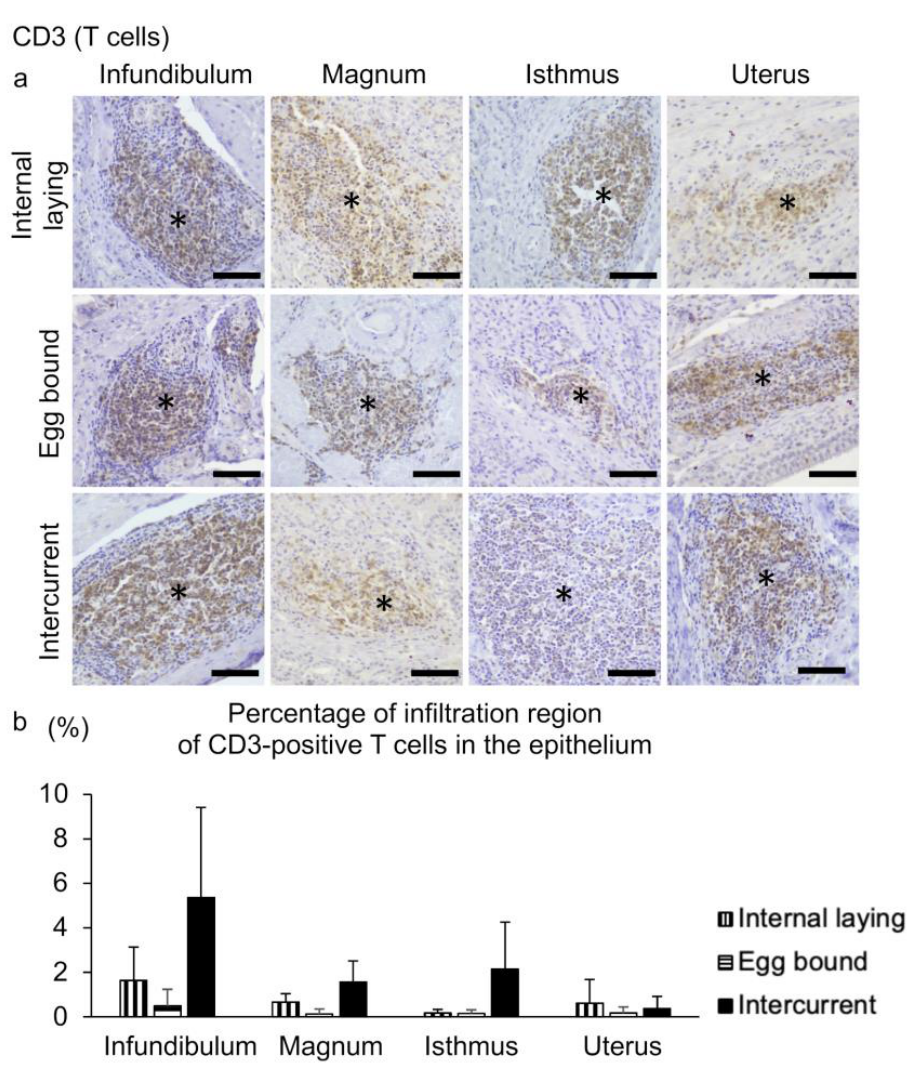
Figure 6. Infiltration of CD3-positive T-cells in the lamina propria of oviducts in the group of internal laying, egg-bound, and intercurrent. ( a ) Immunohistochemistry for detecting CD3-positive T-cells in the lamina propria of oviducts. (*) Asterisks indicate the center of lymphoma-like infiltration of CD3-positive T-cells. Bar = 50 µ m. ( b ) The percentage of infiltration region of CD3-positive T-cells in the epithelium. There are no significant differences among groups (Tukey–Kramer test, n = 4 for each group). Data are presented as the mean + SE.